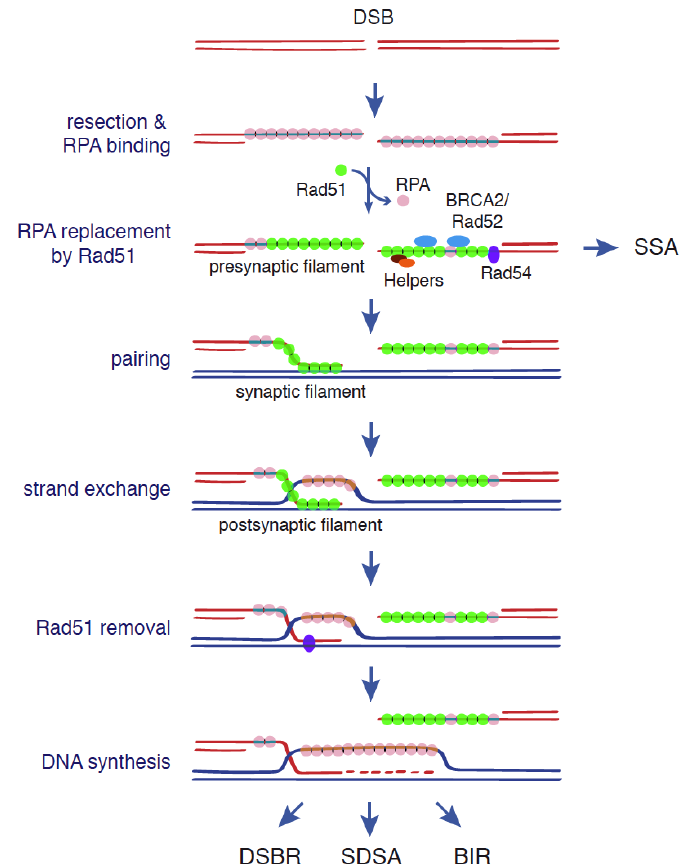
Figure 1. Canonical functions of Rad51, BRCA2, and Rad52 during DSB repair. The central steps in DSB-induced HR are located for homology and strand exchange. They are carried out by a Rad51 nucleofilament formed upon resection of the 5 ′‐ ends of the DSB and subsequent replacement of the ssDNA binding complex RPA with Rad51. This replacement is mediated by BRCA2 in mammalian cells and Rad52 in yeast, with the help of accessory factors. DNA strand exchange leads to the formation of a D-loop structure that is enlarged by DNA synthesis once Rad54 removes Rad51. The final output of the repair will depend on the chosen mechanism: DSBR, SDSA, BIR, or SSA [1,8]. See text for more details.